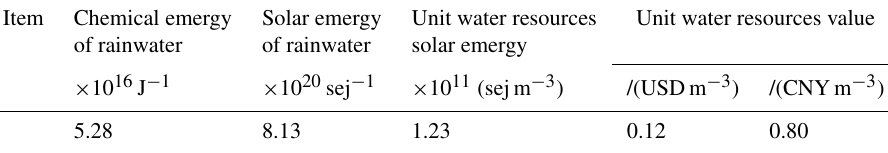
Table 2. Emergy assessment of water resources value in research